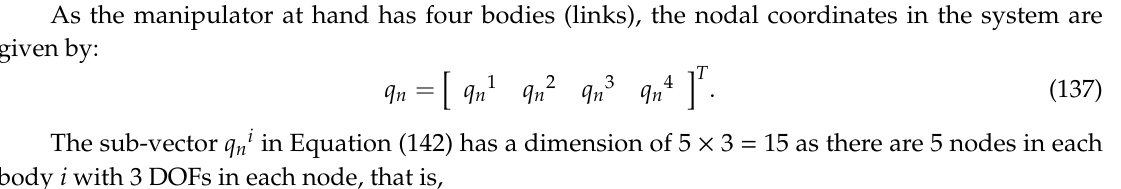
Figure 7. Elements, nodes and nodal coordinates in the body i of the manipulator.